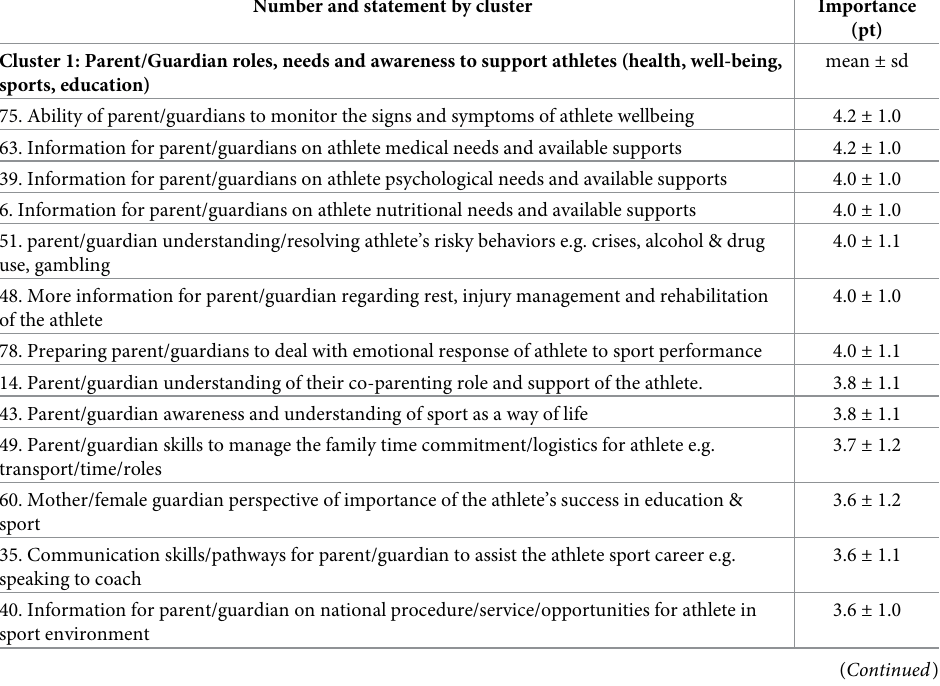
Table 2. Means ± standard deviations of the importance (pt) of identified statements by cluster in ascending